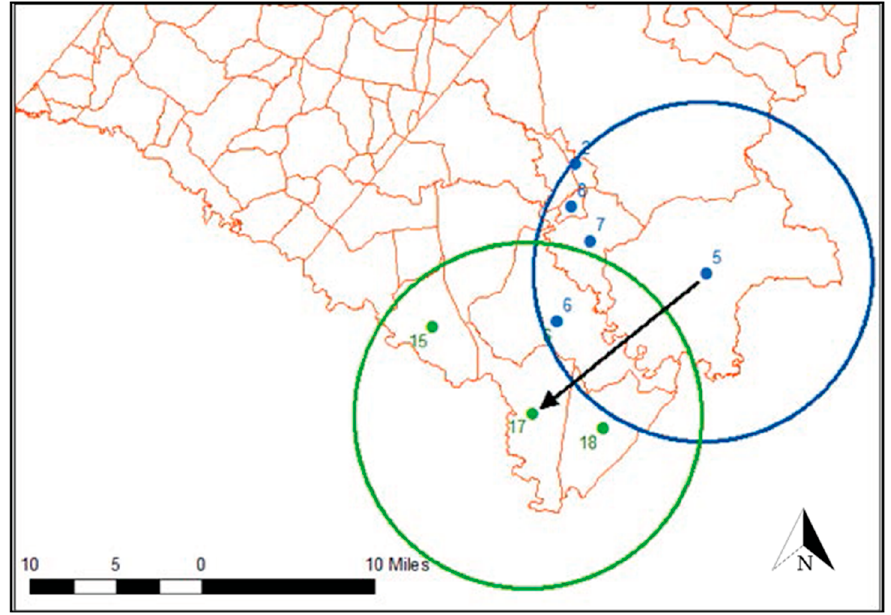
Figure 4. IO and CD Neighborhoods for TAZs 5 and